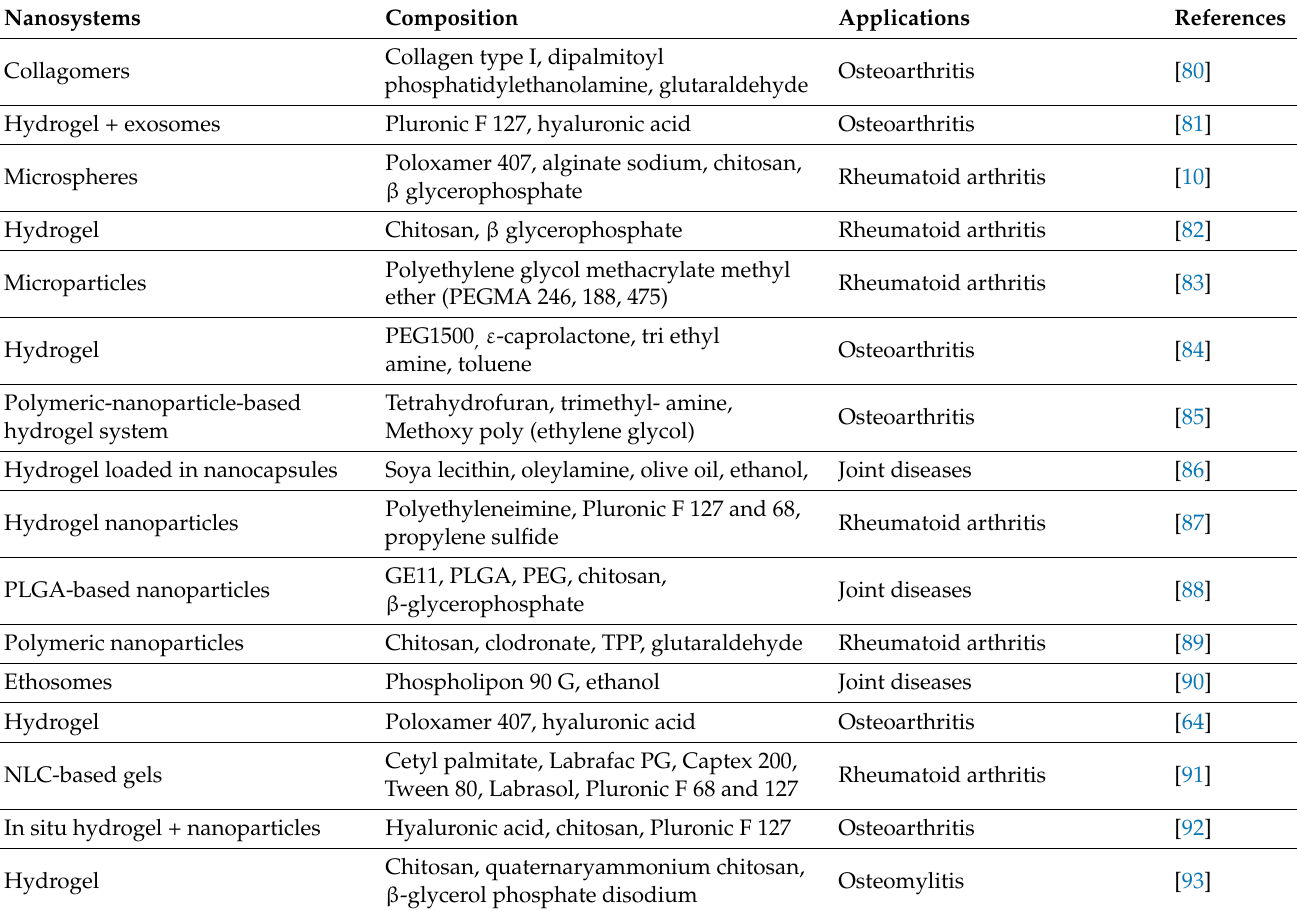
Table 3. Nanostructures used in thermosensitive gels and their